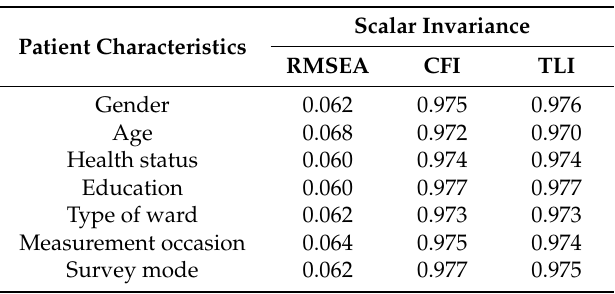
Table 3. Measurement invariance for the modified version of the Flemish Patient